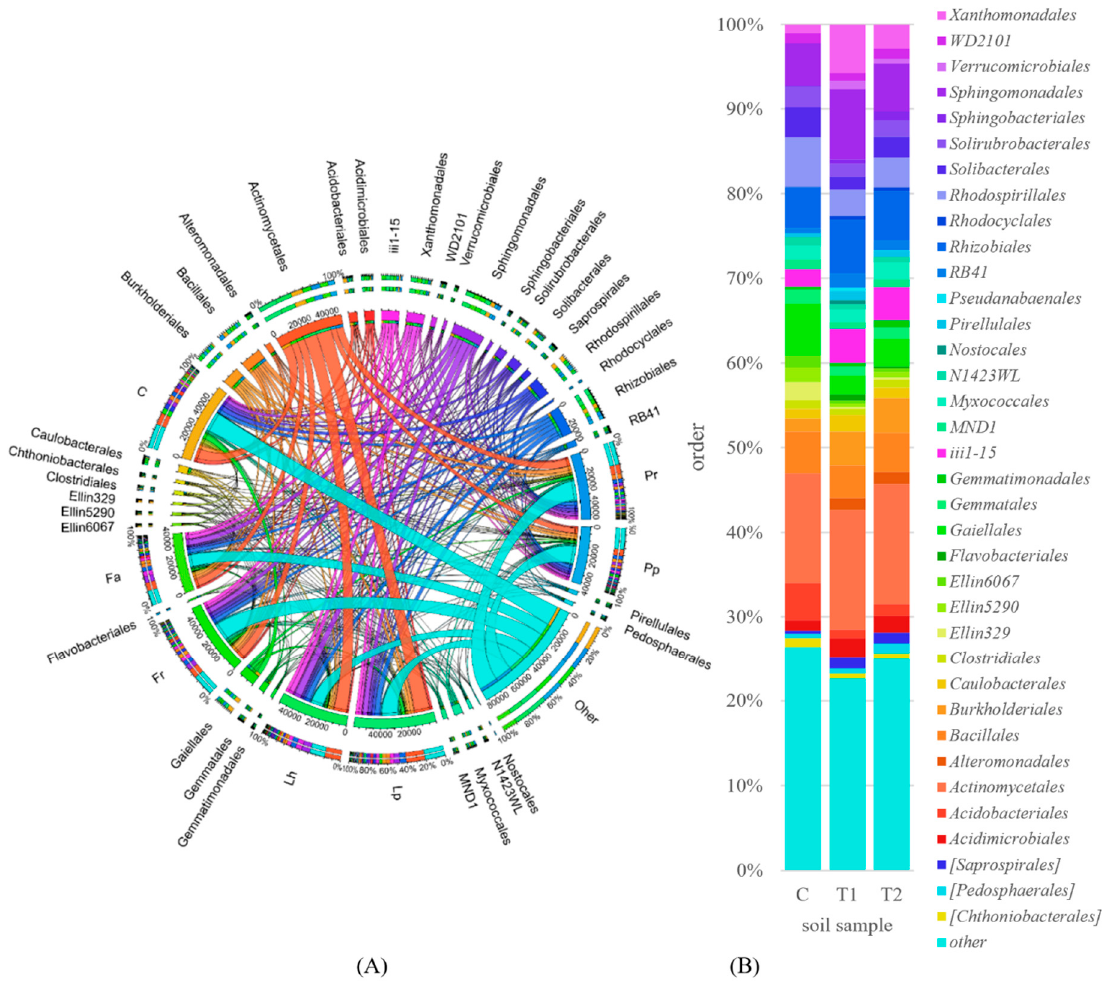
Figure 7. Bacterial communities at the order level ( A ) depending on the species of grass, ( B ) on grass type (fodder or lawn). Abundances < 1% are gathered into the category “other”. C—unsown soil; T1—average bacteria abundance in soils sown with fodder grasses; T2—average bacteria abundance in soils sown with lawn grasses. Lh— Lolium x hybridum Hausskn; Fa— Festuca arundinacea ; Pp—